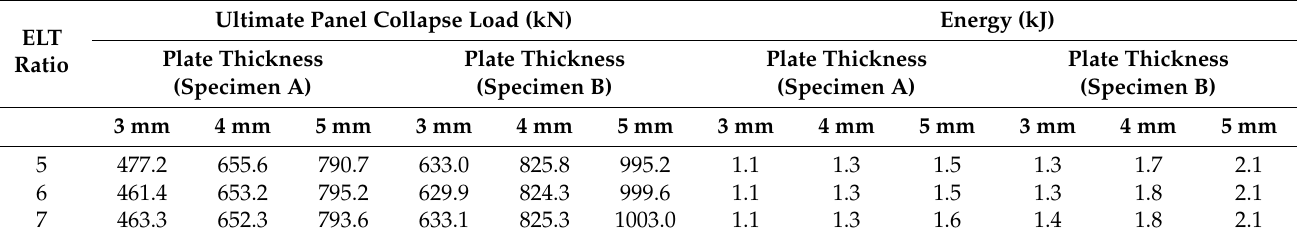
Table 8. Effect of the plate thickness to ultimate panel collapse